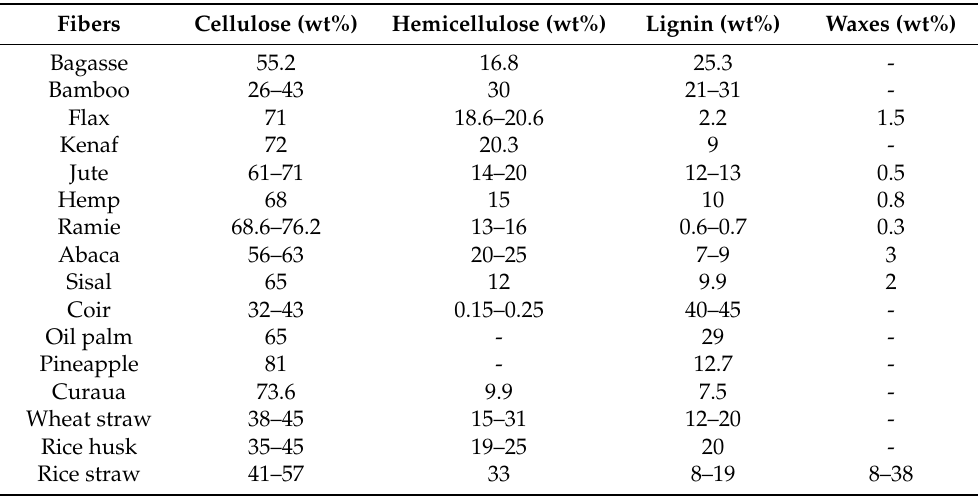
Table 2. Chemical composition of frequently used plant fiber